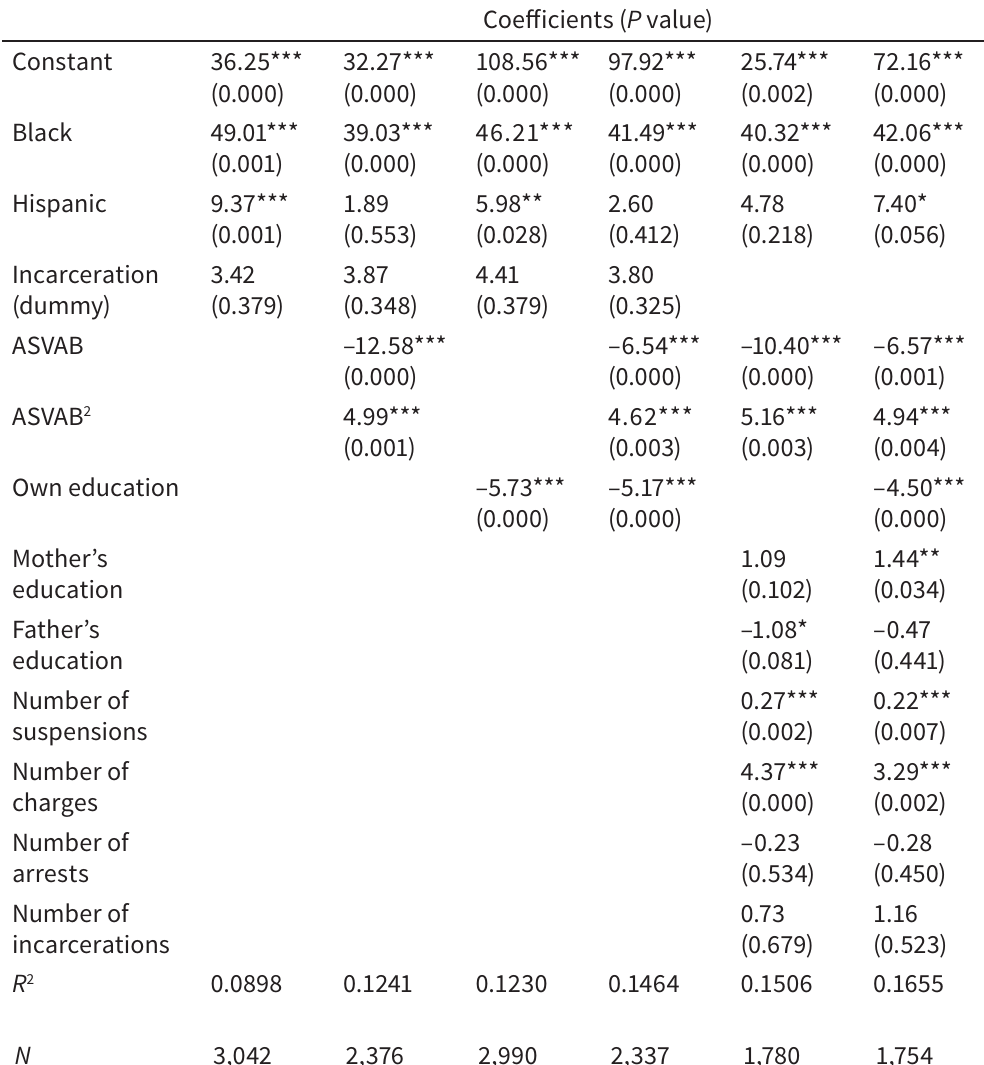
Ordinary least squares regression, weeks unemployed,